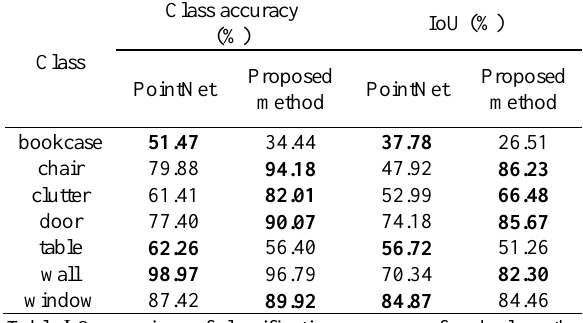
Table Ⅰ Comparison of classification accuracy of each class, the best performance is marked with BOLD fonts.